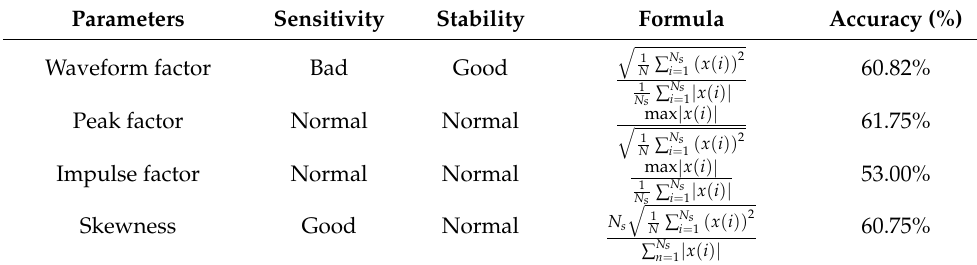
Table 5. The comparison of features sensitivity, stability, calculation formula, and damage identifica- tion accuracy in rail surface